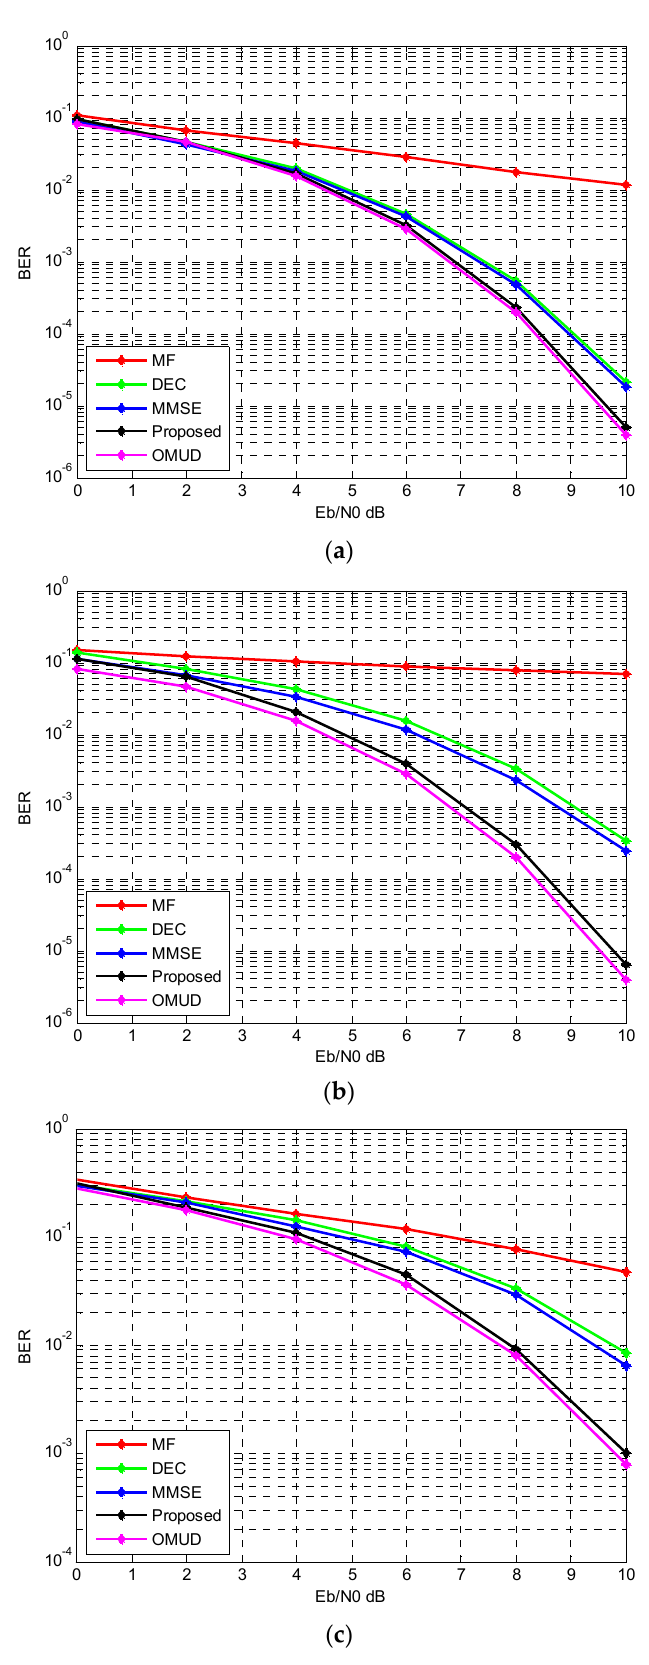
Figure 6. The BER performance with different E b / N 0 . ( a ) AWGN, 20 users; ( b ) AWGN, 50 users; ( c ) IEEE 802.15.4a CM1, 50 users.